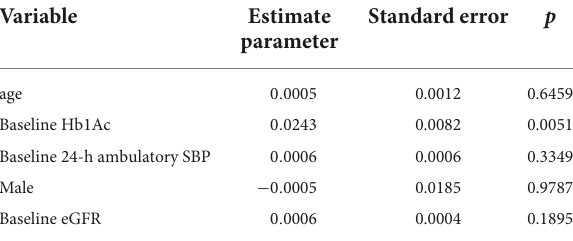
TABLE 4 Multivariate analysis of the factors influencing changes in renal resistive indexes from baseline to 6 months after renal denervation